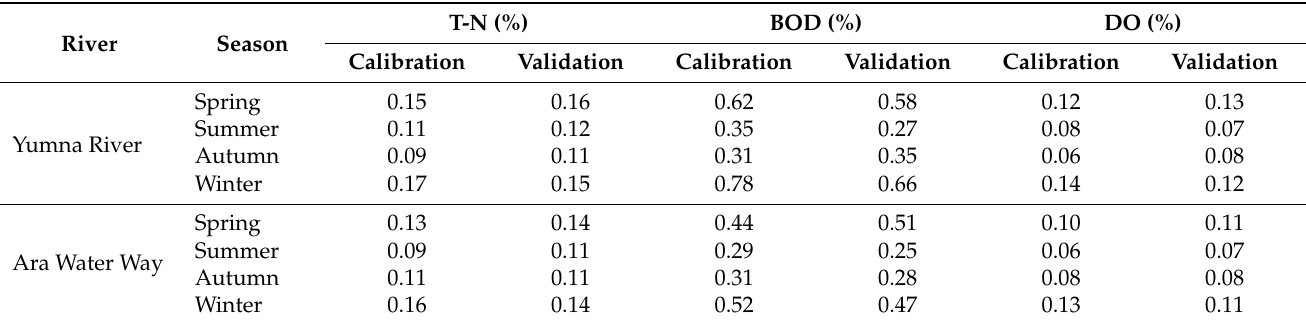
Table 2. Fitting level assessment of the WASP8 outcomes with MAE estimator.